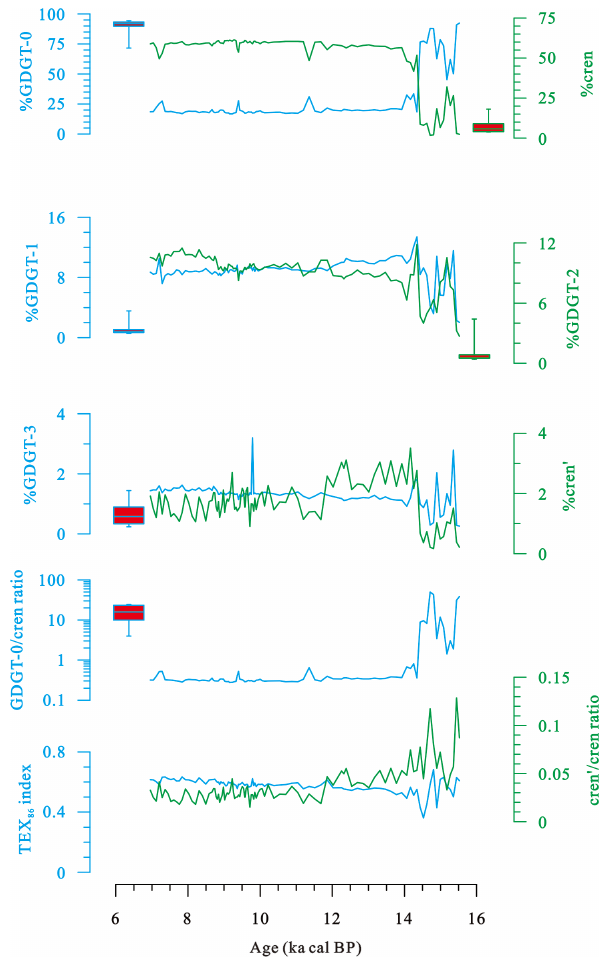
Figure 3. Variations in the relative isoGDGT distribution and isoGDGTs-based proxies of the Lake Chenghai sediment core. The box–whisker plots indicate the values from surface